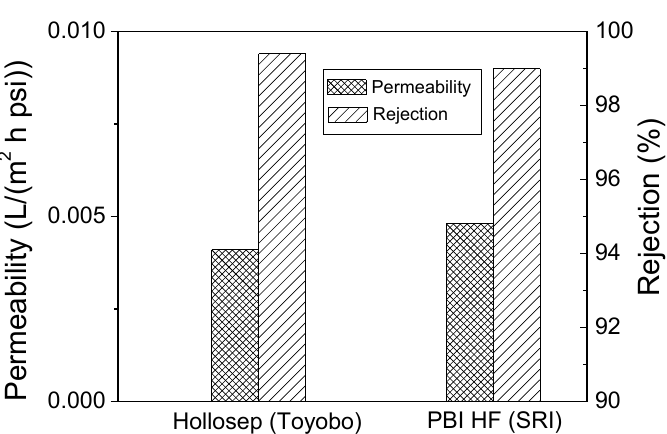
Figure 12 . Comparison of desalination performance of modified PBI HF module (air gap = 2.5″, 6.4 cm) and a commercial HF product.